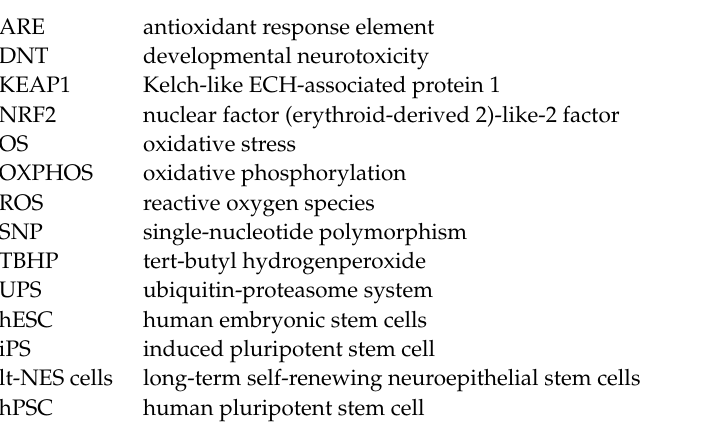
NES cell differentiation, Figure S2: Metabolic changes across lt-NES cell differentiation, Figure S3: NRF2-downstream target gene expression, Figure S4: ML385 treatment leads to decrease in NRF2 protein levels and affects cell viability of proliferative lt-NES, Figure S5: Extended blockade of autophagic flux in differentiated lt-NES cells, Figure S6: Characterization of 20S related proteasomal subunit β 5 expression along lt-NES cell differentiation, Figure S7: 20S activity can be blocked by MG132 treatment, Figure S8: Autophagy induction upon MG132 treatment, Figure S9: Quantification of Western blot data of KEAP1 protein levels in lt-NES cells differentiated for up to 12 weeks treated for 17 h with MG132, Figure S10: The proteasome is regulating KEAP1-NRF2 pathway activation under acute oxidative stress conditions also in lt-NES cells differentiated for 6 weeks. Table S1: Inhibition concentration 20 (IC20) and 50 (IC50) value estimation from dose–response curve